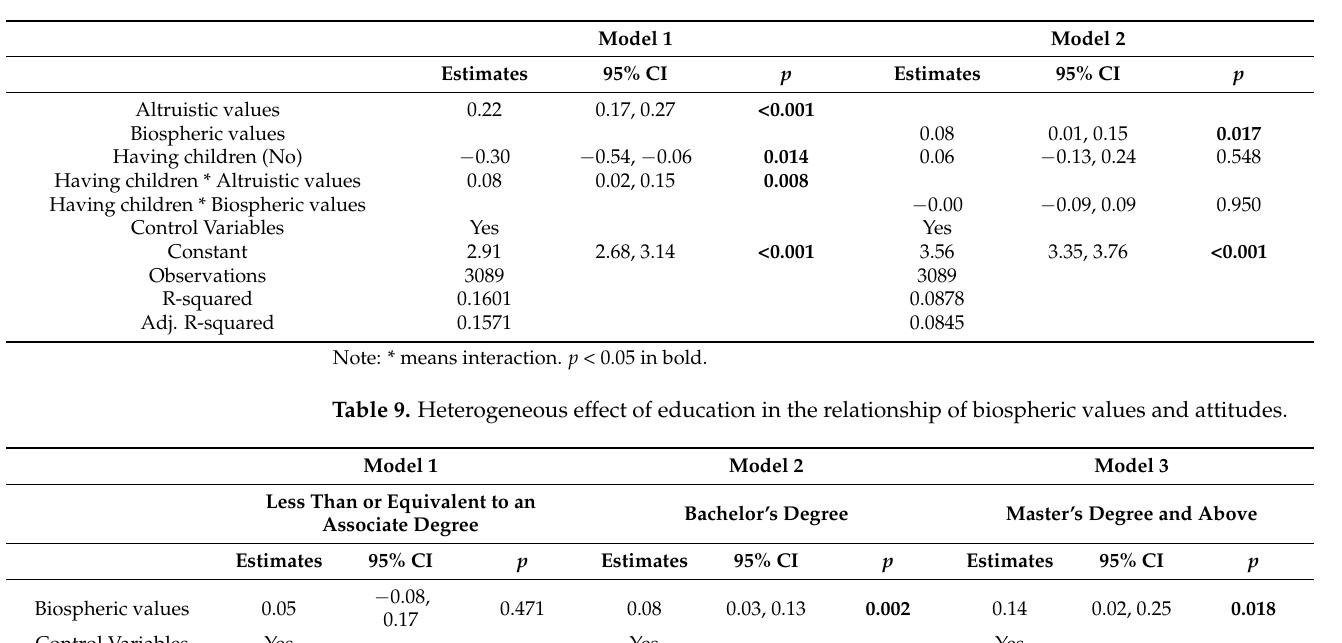
Table 8. Moderating effect of having children on the relationship between altruistic values and attitudes.